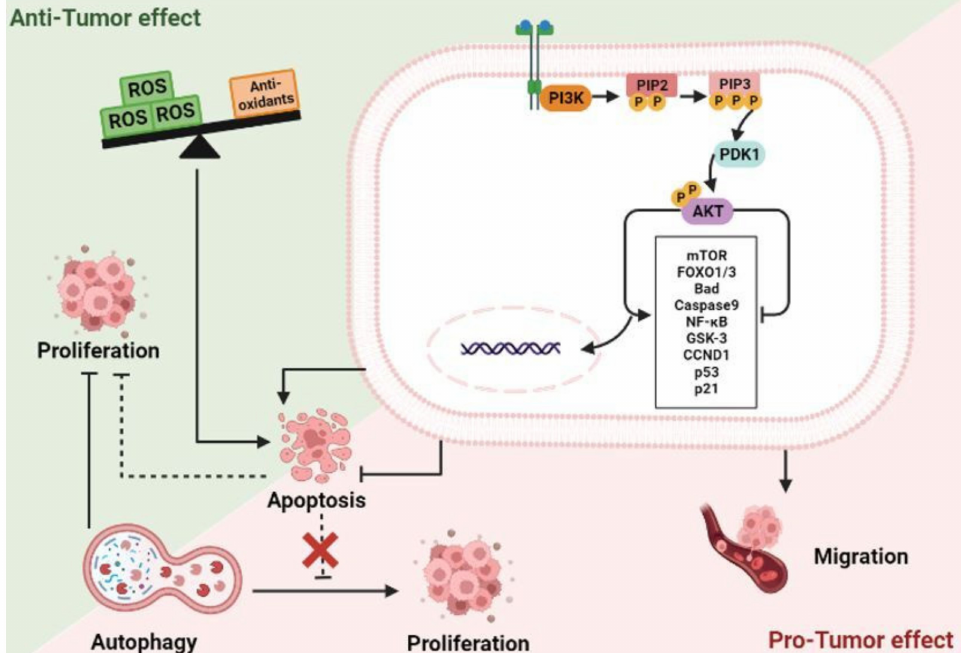
Figure 4. The PI3K/AKT signaling pathway in colorectal cancer. PI3K/AKT plays a double role in cancer as a survival and deadly signaling. Activated AKT regulates cell proliferation, differentiation, migration, and apoptosis in CRC by activating or inhibiting downstream target proteins, such as Bad, Caspase 9, NF- κ B, GSK-3, FOXO1/3, p21, and p53. It can suppress tumor proliferation also by decreasing the expression of antioxidant enzymes and increasing the production of ROS, thereby inducing cell apoptosis. In contrast, PI3K/AKT could modulate the expression of pro-apoptotic factors to inhibit apoptosis. Autophagy is another process controlled by PI3K/AKT/mTOR signaling. It is a double-edged sword in cancer. It can inhibit or induce cell proliferation.